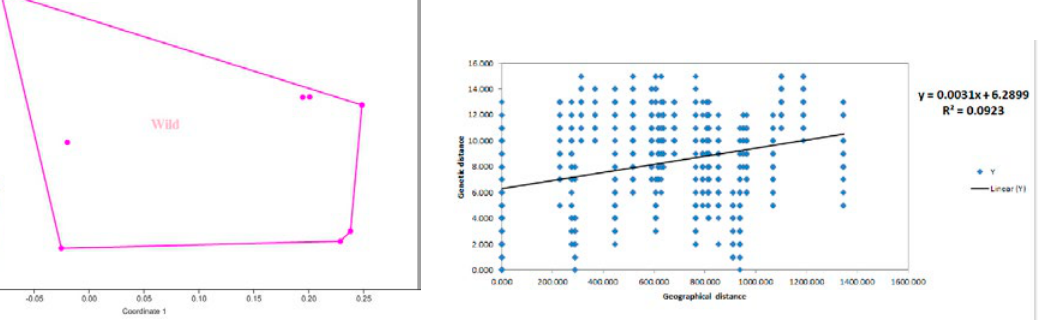
Figuse 6. Mantel test plot between genetic distance and geographi- cal distance of Z. Jujube